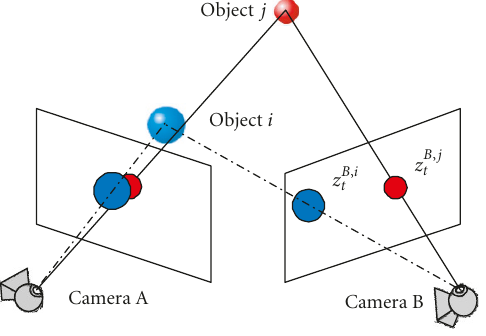
Figure 4: The model setting in 3D space for camera collaboration likelihood